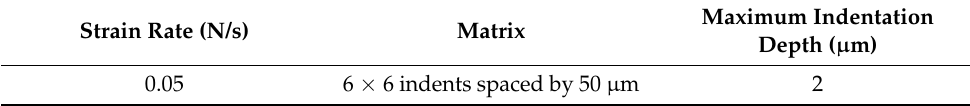
Maximum Indentation Depth ( µ m)